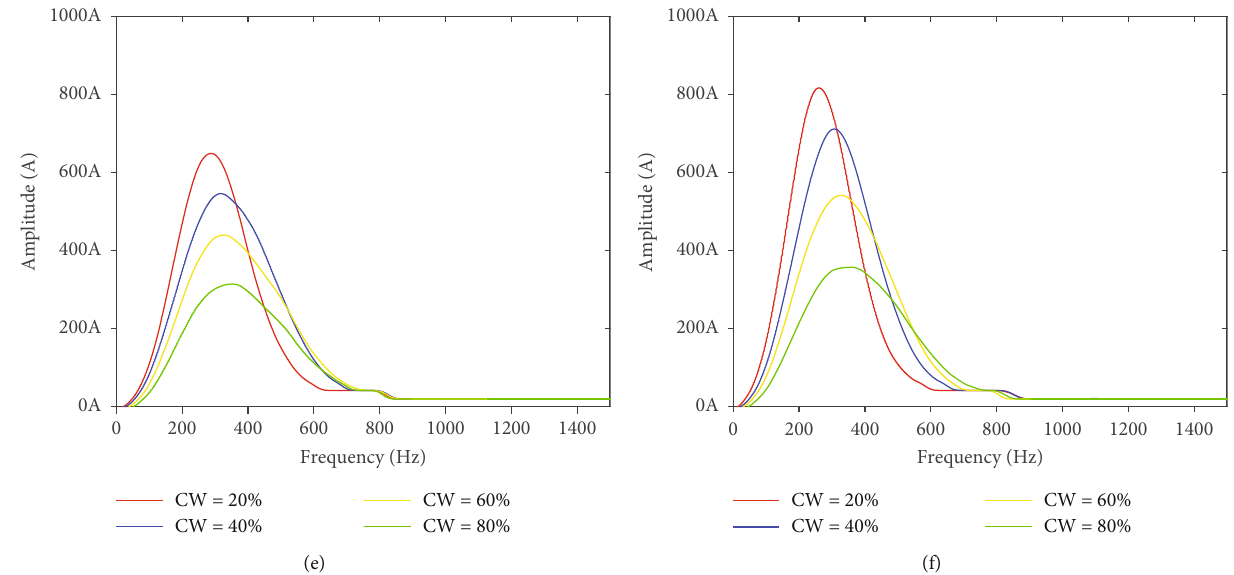
Figure 5: Power spectrum curve of oil-water two-phase fl ow: (a) Qm = 10 m 3 /d , (b) Qm = 15m 3 /d , (c) Qm = 20m 3 /d , (d) Qm = 25 m 3 /d , (e) Qm = 30 m 3 /d , and (f) Qm = 40 m 3 /d .